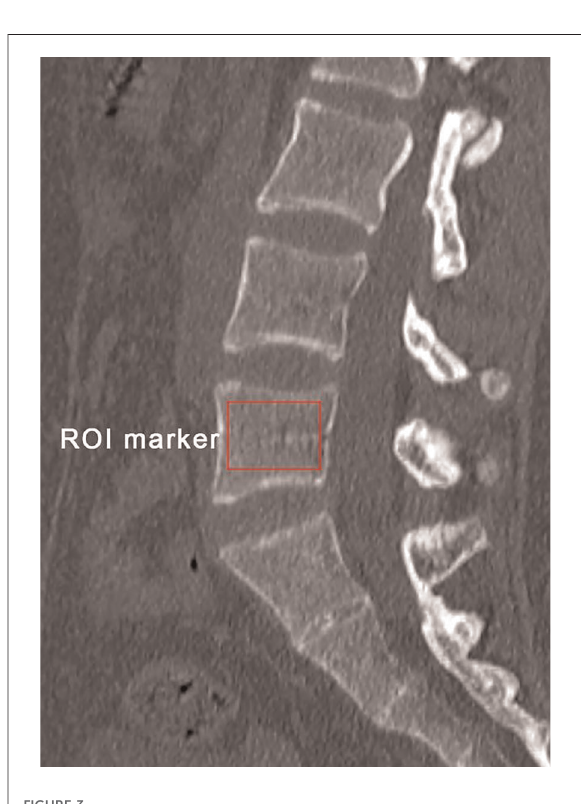
FIGURE 3 Schematic diagram of bone mineral density measurement of the vertebral body: obtained by measuring the HU value of L5 on the sagittal reconstructed CT image.